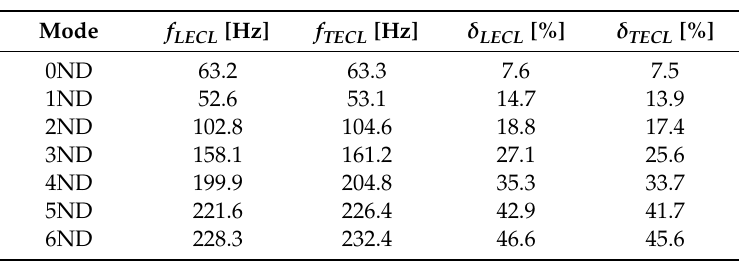
Figure 15. ( a ) Size and location of the leading edge attached cavitation on the blades of the runner; ( b ) size and location of the trailing edge attached cavitation on the blades of the runner. Table 7. Natural frequencies of the runner with cavitation ( f ) and frequency reduction ratios ( δ ) of the modes from 0 to 6 nodal diameters (ND).